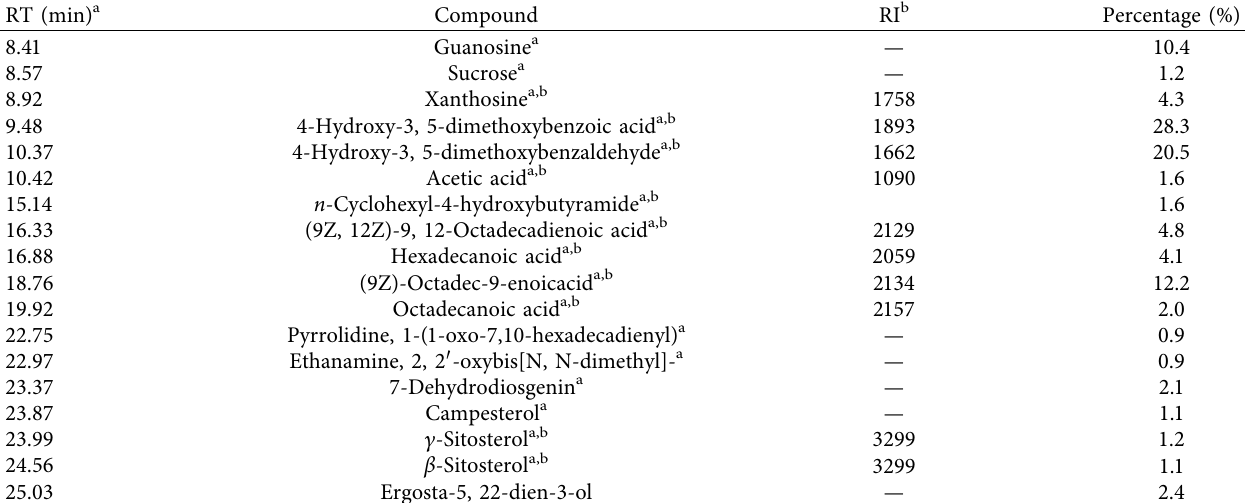
Table 2: GC-MS analysis results of rape pomace